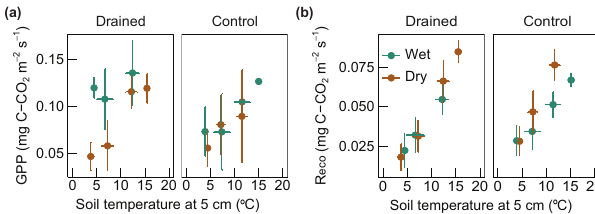
Figure 6. Links between average T soil at 5cm and (a) GPP and (b) R eco rates by transect (column). Data are from 2013 (20 July– 10 August) and subseason 2014.3 (27 July–20 August); both cover similar phenological periods. Data were grouped into temperature bins of 5 ◦